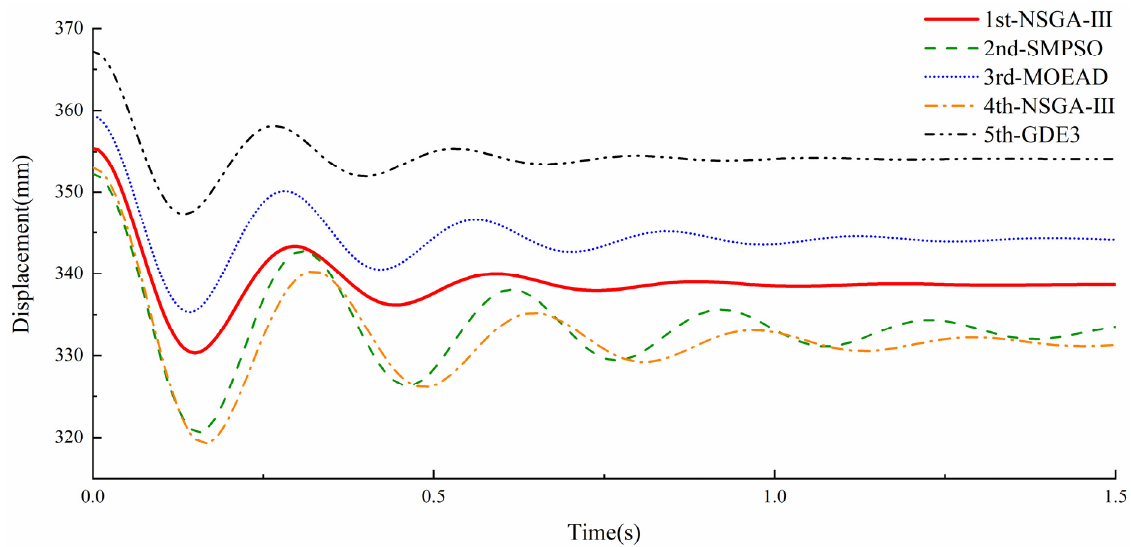
Figure 4. The quarter suspension modal barycenter’s acceleration time response curve.